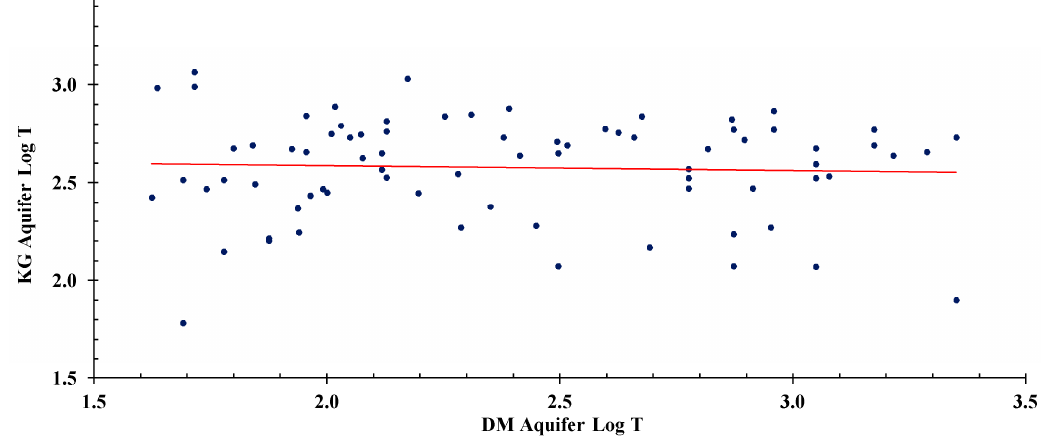
Figure 14. Regression analysis between Kg log T and Dm log T values.